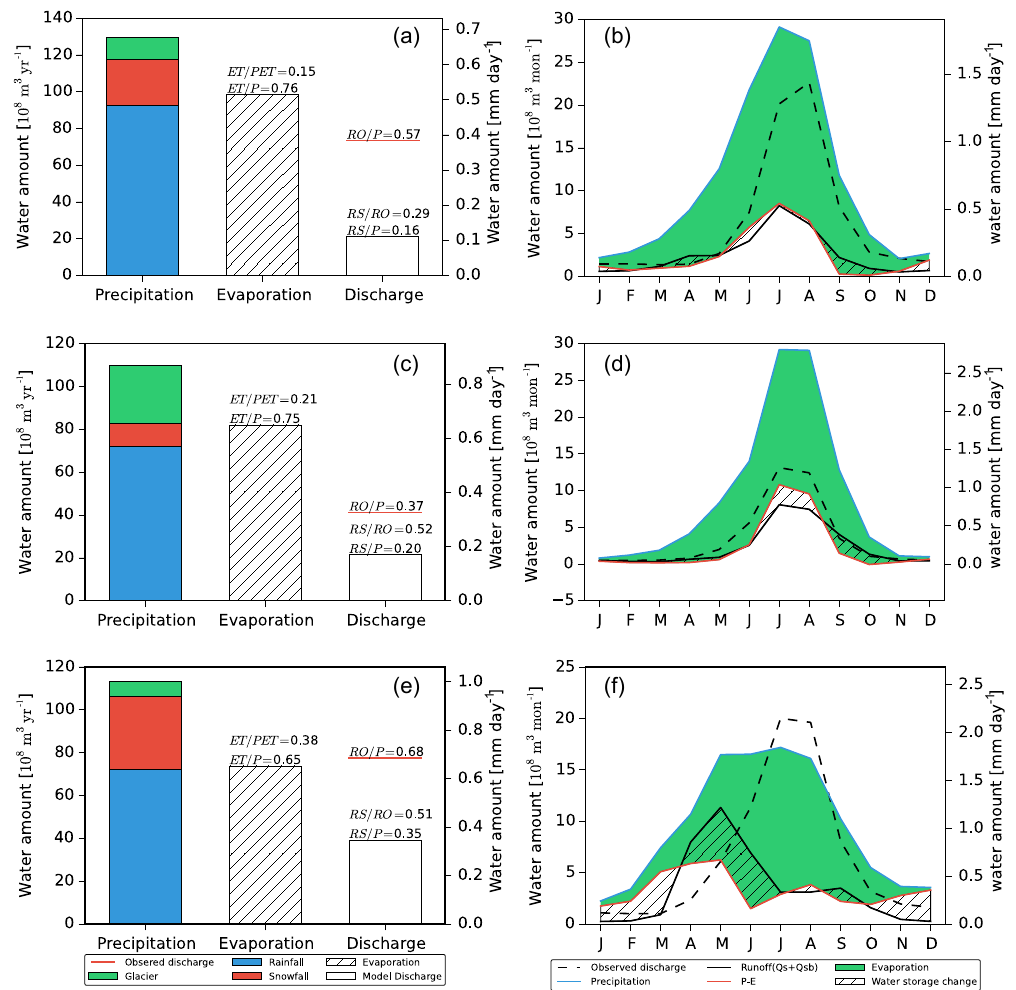
Figure 8. The water input components (rainfall, snowfall, glacier melt), evapotranspiration and discharge for three headwater catchments (from top to bottom: a , Yarkand; c , Hota; and e , Aksu) in the WFDEI-CCG-SF simulation. In the left panels, the amounts of different variables are plotted as bars, while the average mean of the observed discharge (RO) is plotted as the red line. RS denotes the simulated discharge by ORCHIDEE. In the right panels, the annual cycle of the water inputs (blue line), evapotranspiration (green shadow), estimated discharge (runoff plus drainage, solid black line), observed discharge (dashed black line) and changes in terrestrial water storage (TWS, slashed area) are plotted as b , d and f . The green slashed area represents decreasing in TWS, and the white slashed area represents increasing in